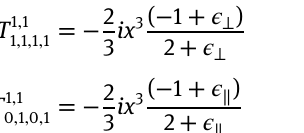
Figure 3: MD and ED dipole comparison between the QS and full T -matrix approach. (a) The T -matrix extinction spectrum (black solid line) of a hyperbolic sphere with r = 50 nm ( k ∥ , E ⊥ ) is reproduced correctly for the ED and MD only when accounting for 4 plane waves = 2). (b) The QS ( n 𝛽 = 4) and the first two multipole orders ( n rank approximation yields good scattering albedo for the ED resonance up to r ≲ 20 nm. The QS scattering albedo of the MD is overestimated in a broad size range, however, (c and d) the QS-calculated MD peak position (and the ED one) agrees very well with the T -matrix-derived